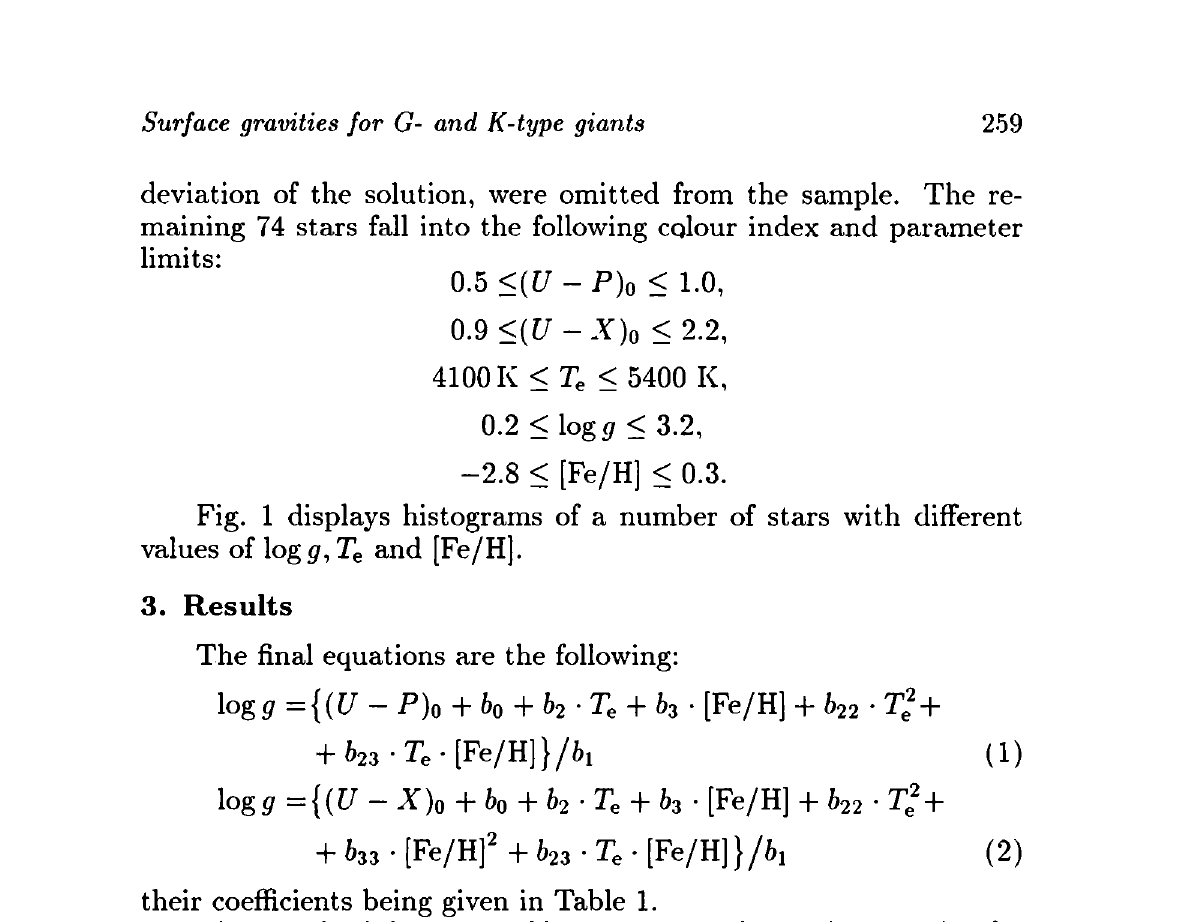
Table 1. Values of coefficients of the calibration Equations (1) and